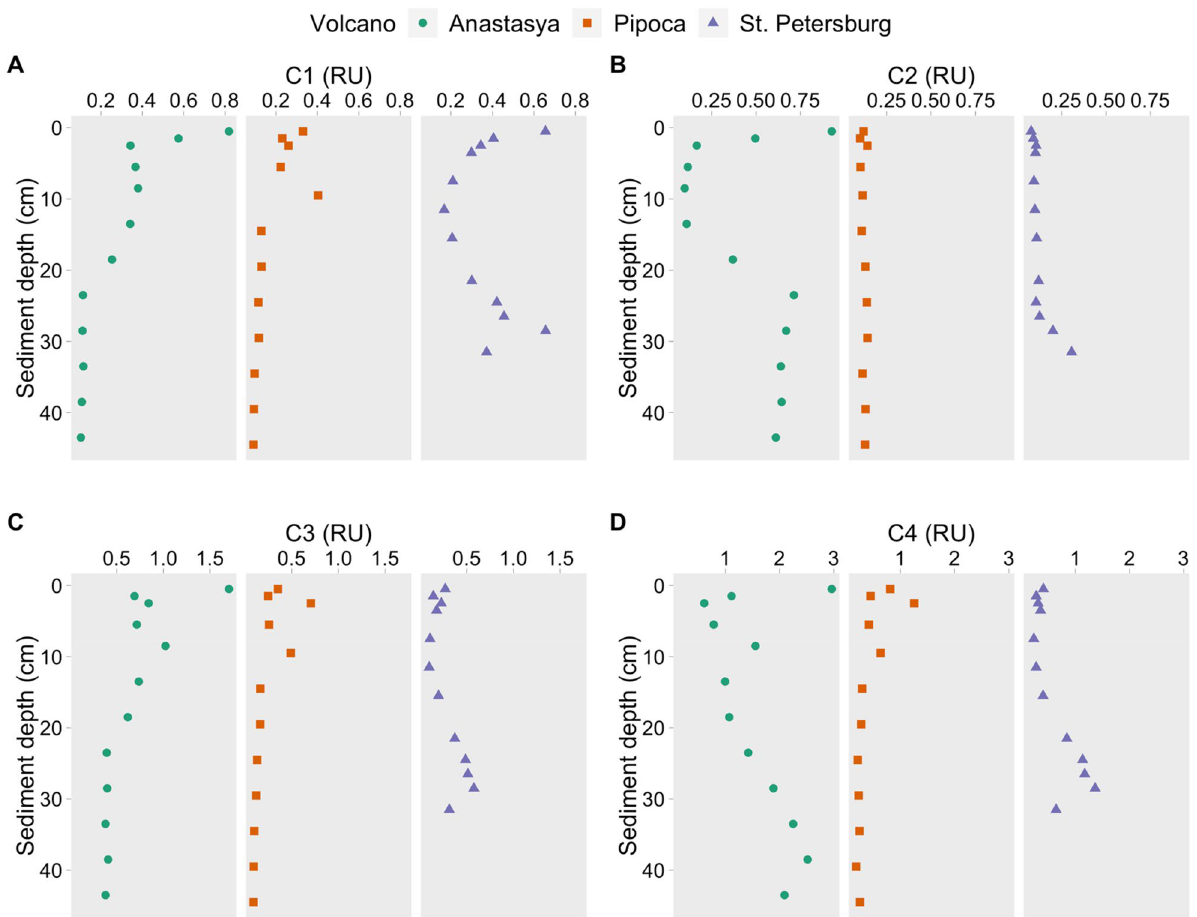
Figure 3. Pore water profiles of the PARAFAC fluorescent components ( A : C1, B : C2, C : C3 and D : C4) in the three mud